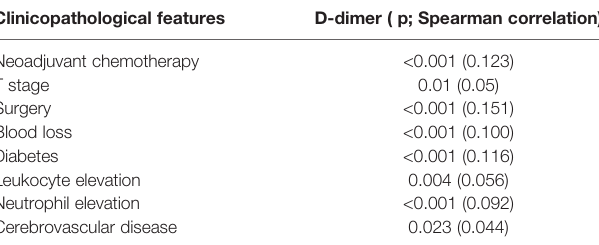
TABLE 1 | Characteristics of population by D-dimer increase level (n = 2706).